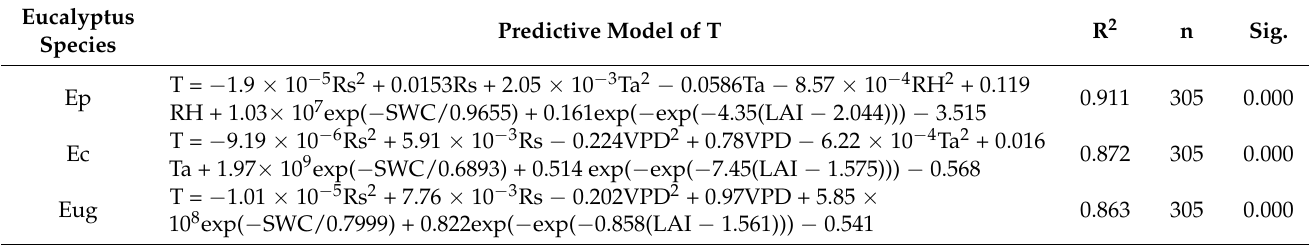
Table 3. The integrated model for predicting daily stand transpiration (T) of three eucalyptus species.